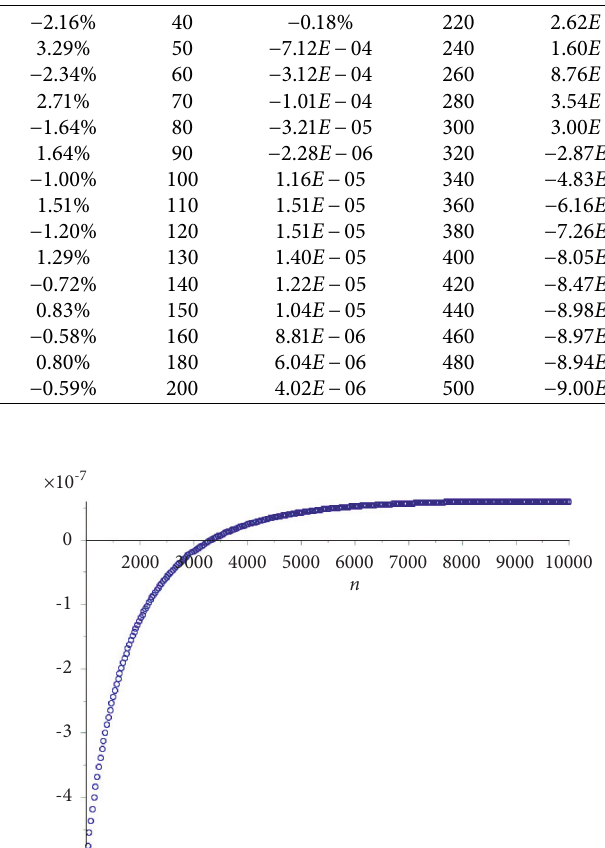
Figure 19: The relative error of I Table 7: The relative error of I